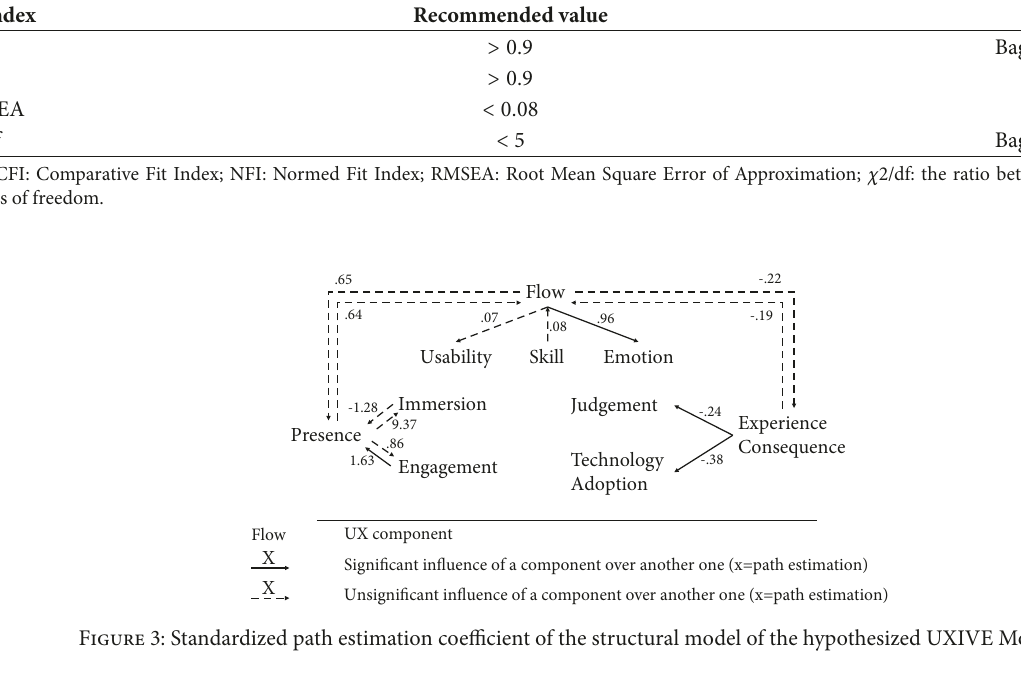
Usability Measures . Usability was measured through